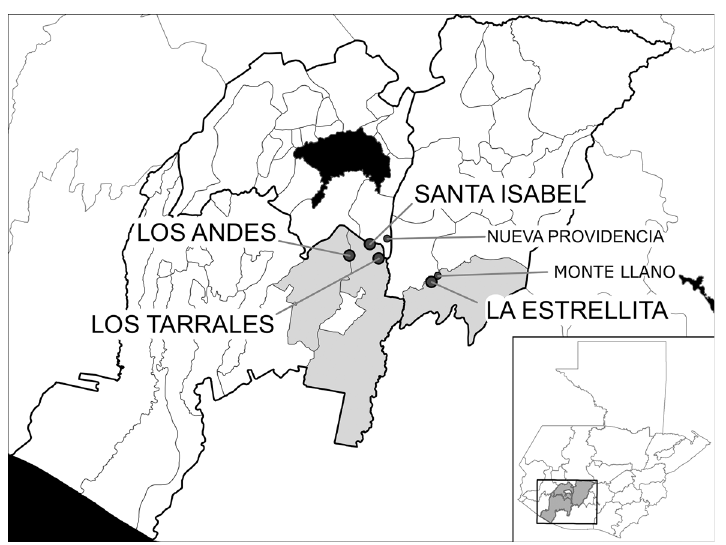
Fig 1. Names and locations of study communities included in the KAP survey in the Central Endemic Zone (CEZ) for onchocerciasis, Guatemala. The questionnaires were pre-tested in Nueva Providencia and Monte Llano (shown using a smaller font size). The grey color in the inset outlines the departments in which the CEZ is located. The grey color in the main map shows the counties ( municipios ) where the four study communities were located. The black color represents Lake